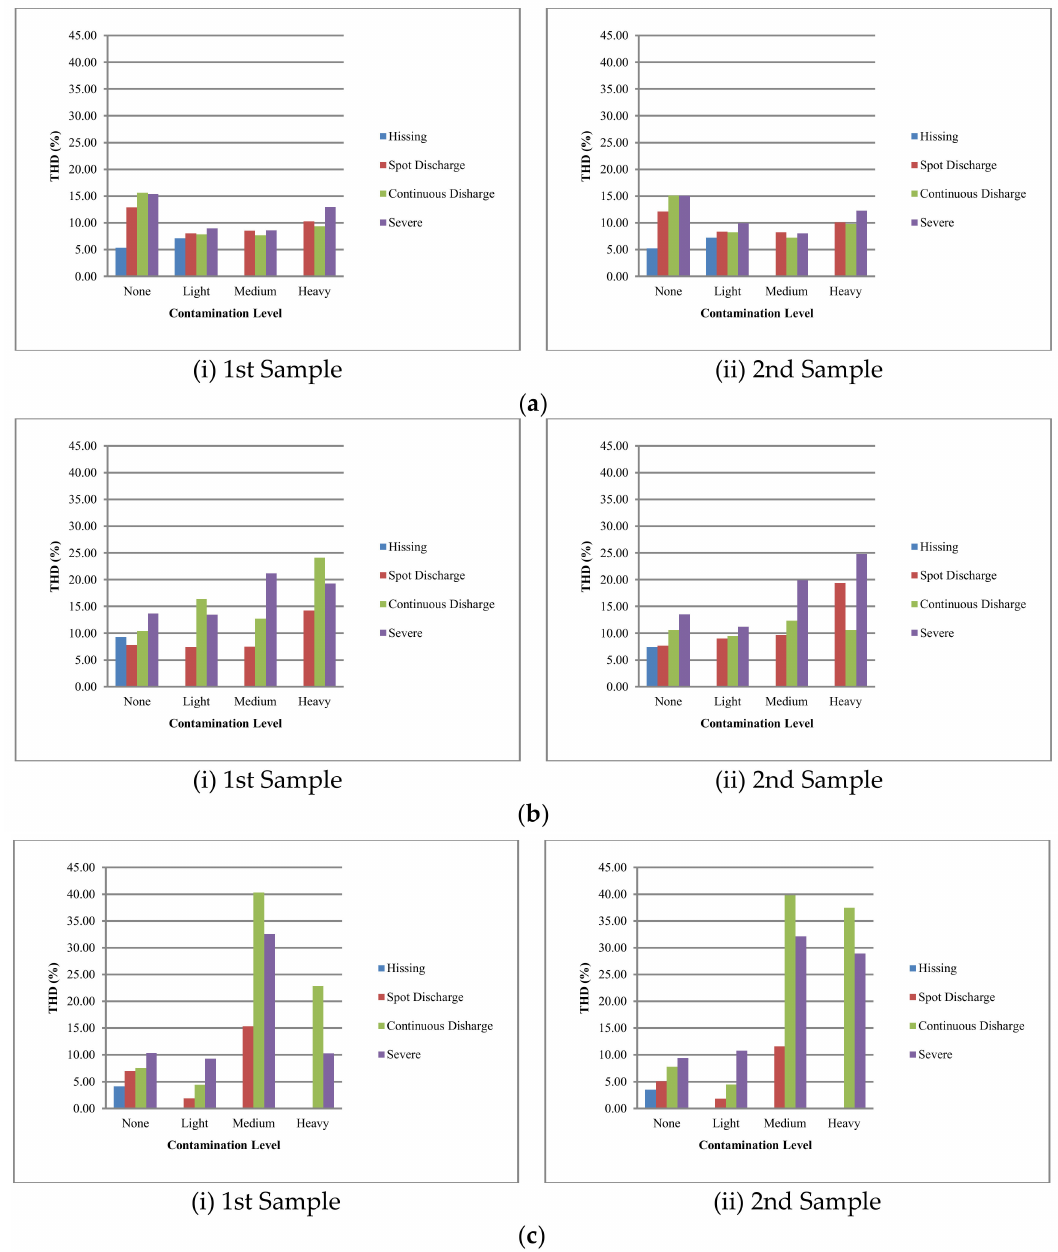
Figure 15. THD (%) for wet insulator condition for samples of: ( a ) Group A; ( b ) Group B; ( c ) Group C